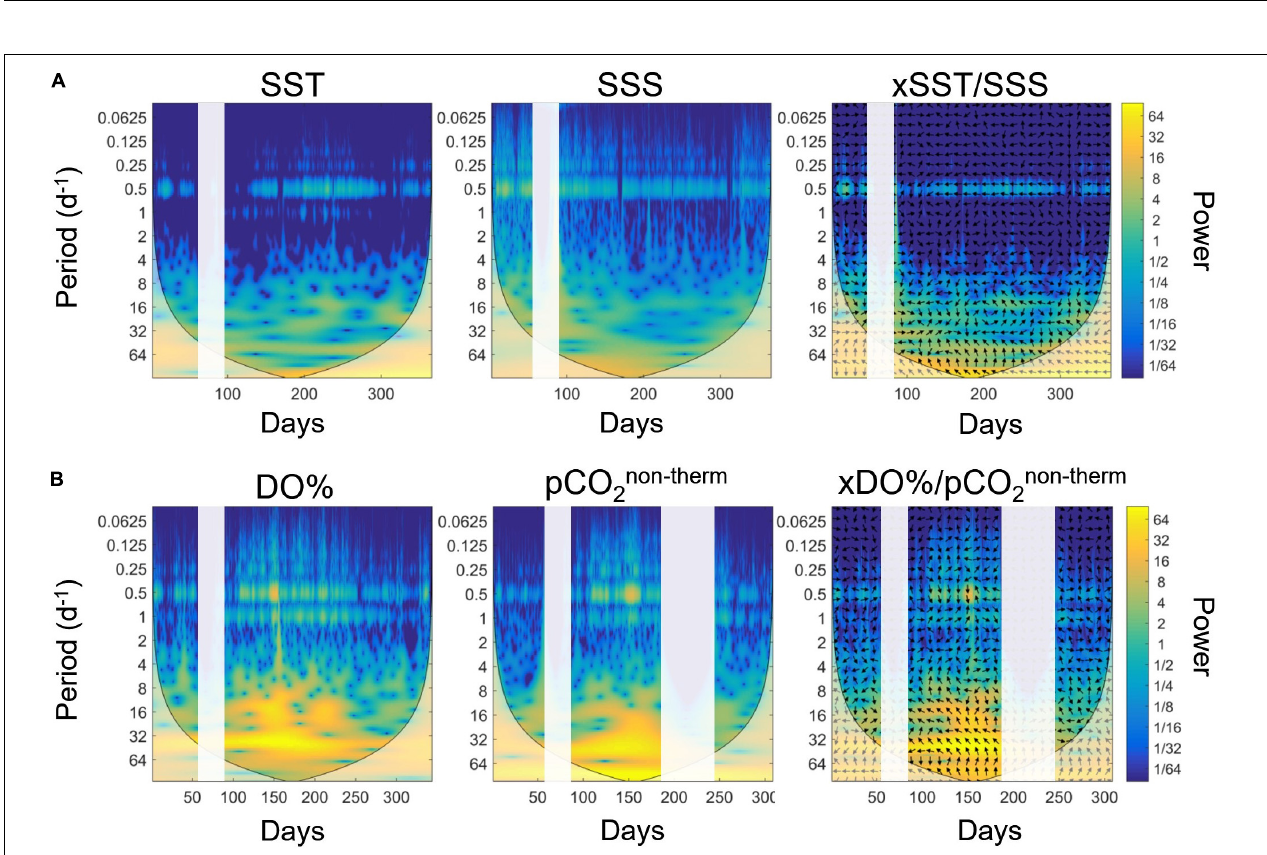
FIGURE 5 | Wavelet power spectrum based on the Morlet wavelets during the year 2016 for (A) SST ( ◦ C), SSS, and cross-wavelet spectrum between SST and SSS, and for (B) DO% (%), pCO 2 non − therm ( µ atm) and cross-wavelet spectrum between DO% and pCO 2 non − therm . Time is expressed in day of the year. The color bars represent the power of the wavelet transform, in absolute squared value. A high power is represented in yellow. For the cross-wavelets spectrum, the arrows indicate if the signals are in phases (arrow pointing right) or in phase inversion (arrow pointing left). White bands represent a lack of data.